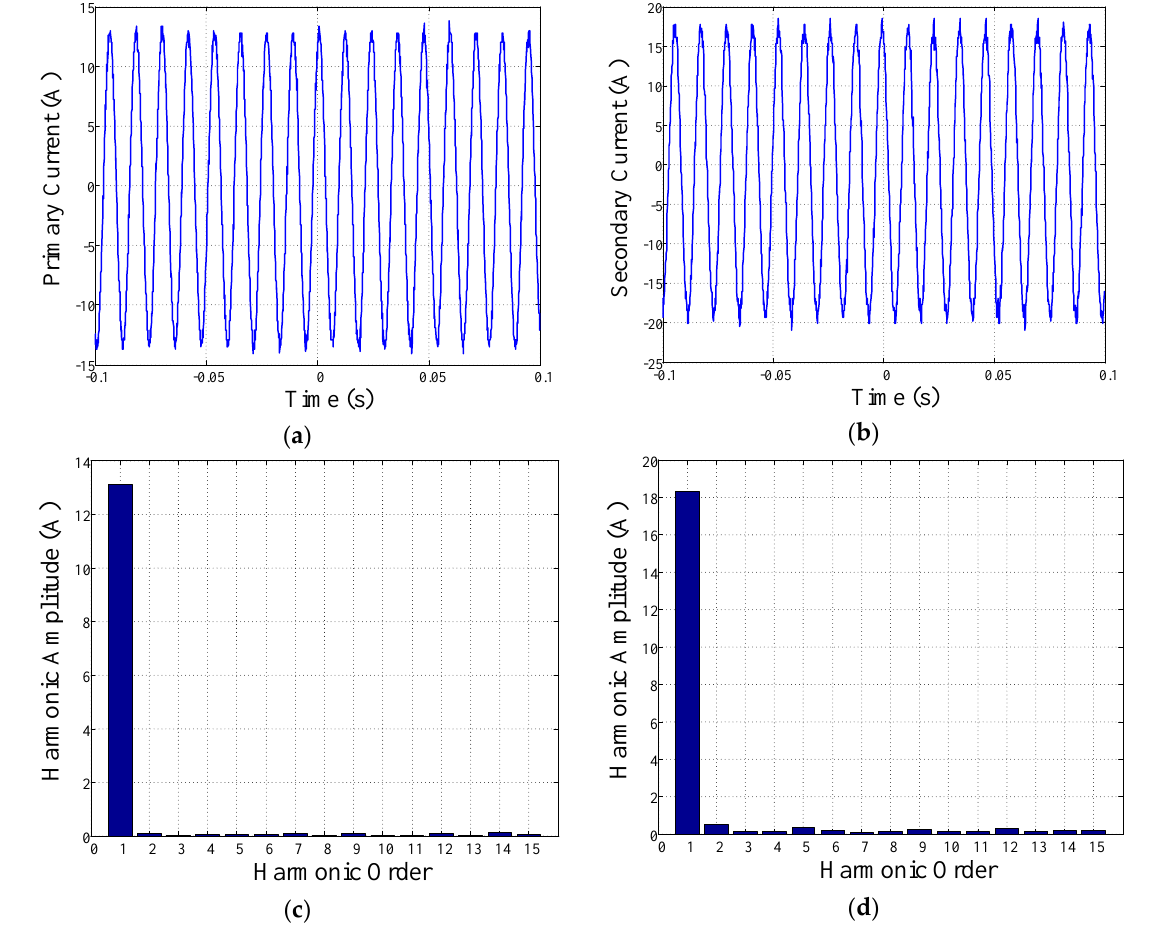
Figure 16. Winding currents of the DSFM motor at 924 rpm: ( a ) primary winding current; ( b ) secondary winding current; ( c ) the harmonic content of the primary current; and ( d ) the harmonic content of the secondary current.